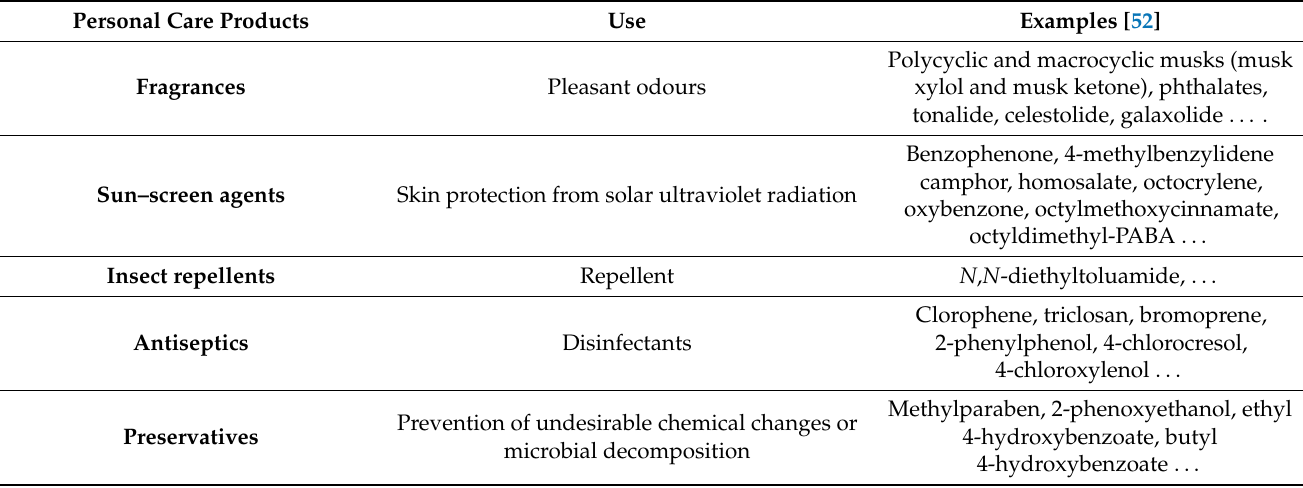
Table 3. Classification and functions of personal care